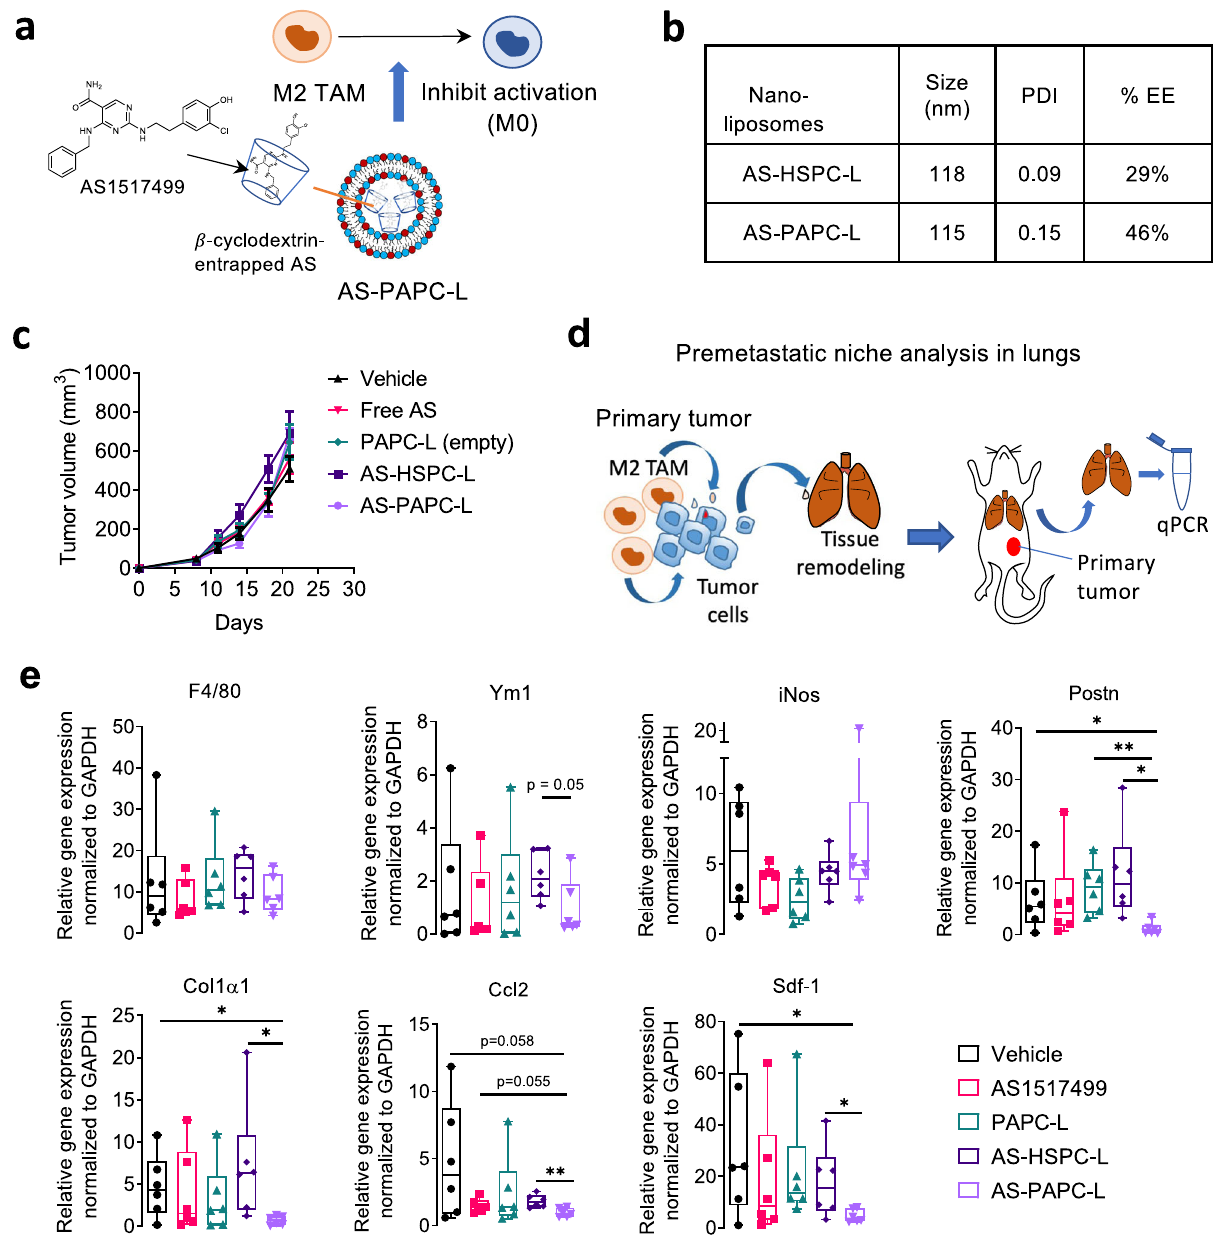
including cytokines, extracellular vesicles which form metastatic niche in lungs. Lungs from the tumor-bearing mice were isolated and analyzed with quantitative polymerase chain reaction (qPCR). e Graphs showing quantitative real-time PCR resultsfortheeffectofAS-HSPC-LandAS-PAPC-Lonthemarkersforpre-metastatic niche in lungs. N =6 mice per group (left to right, Postn: * p =0.049, ** p =0.0032, * p =0.017; Col1 α 1: * p =0.025, * p =0.041; Ccl2 ** p =0.0046; Sdf-1: * p =0.041, * p =0.049. Data represent the box-and-whisker plot where every dot represents a data point and the line in the box corresponds to the median. The boxes go from the upper to the lower quartiles, and the whiskers go from the minimum to the maximum value. Statistical analysis was performed with unpaired two-tailed Stu- dent ’ s t -test. Source data are provided as a Source Data fi